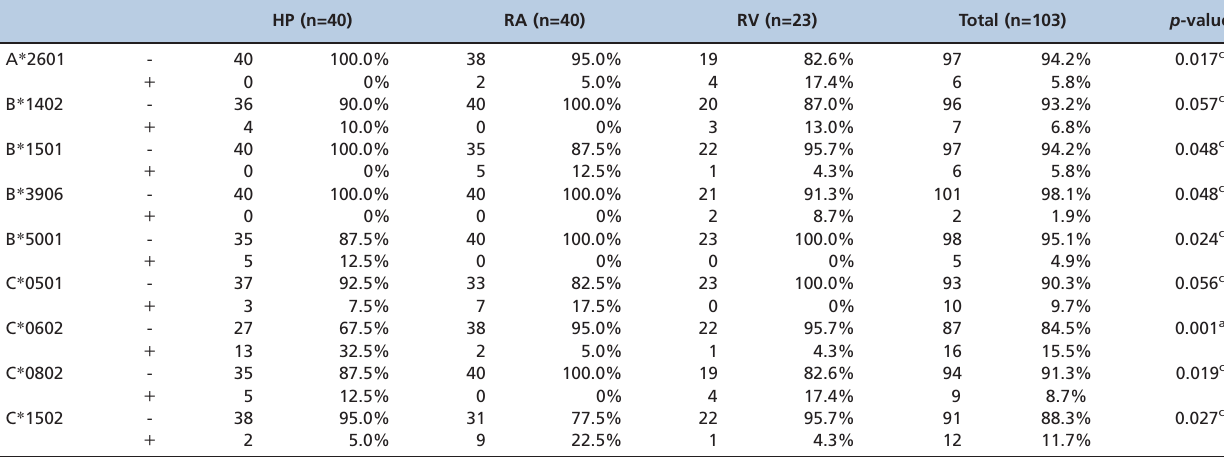
Table 2 - Distribution of the HLA-A/B/C allelic frequencies among the patient